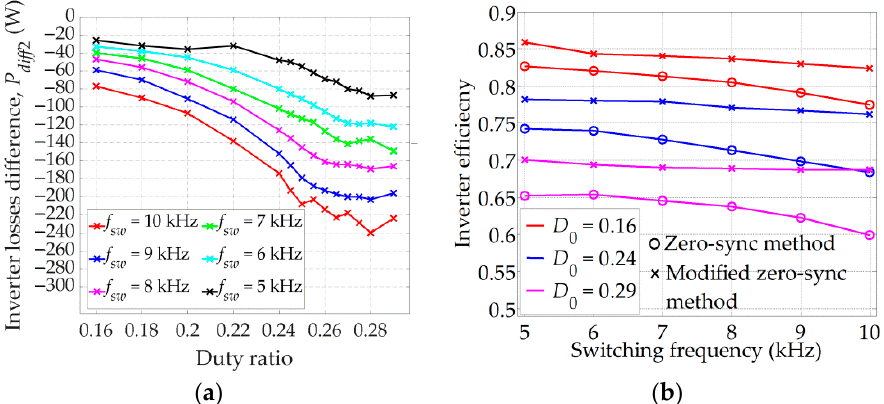
Figure 20. Inverter losses difference ( P diff 2 ) as a function of the duty ratio for different switching frequencies ( a ); inverter efficiency as a function of the switching frequency for different duty ratio values ( b ).